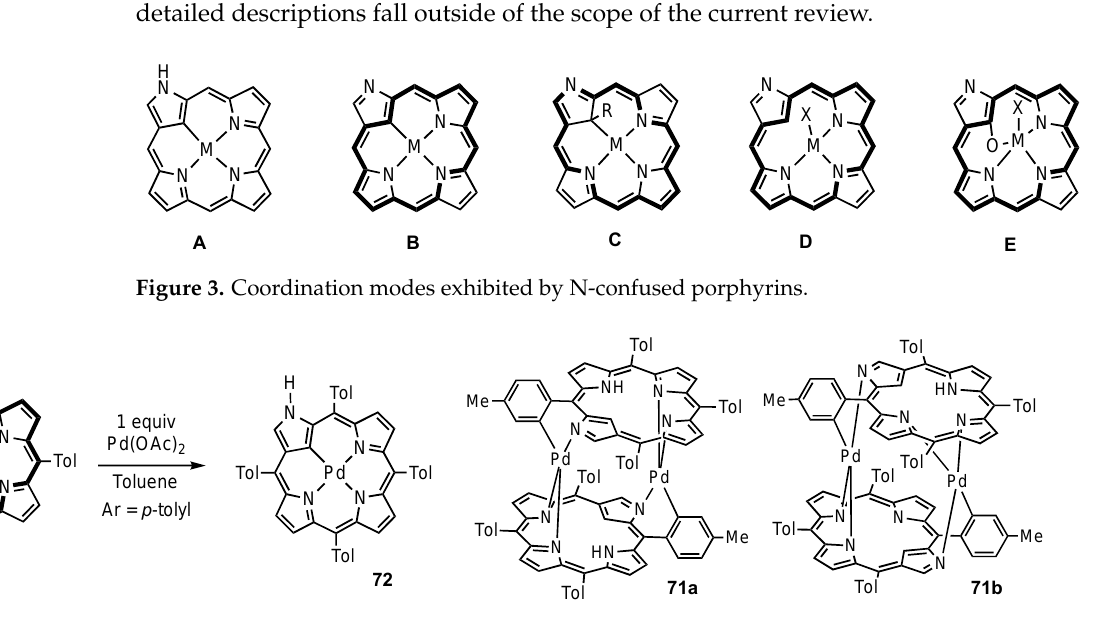
Scheme 16. Palladium complexes of N-confused porphyrins.